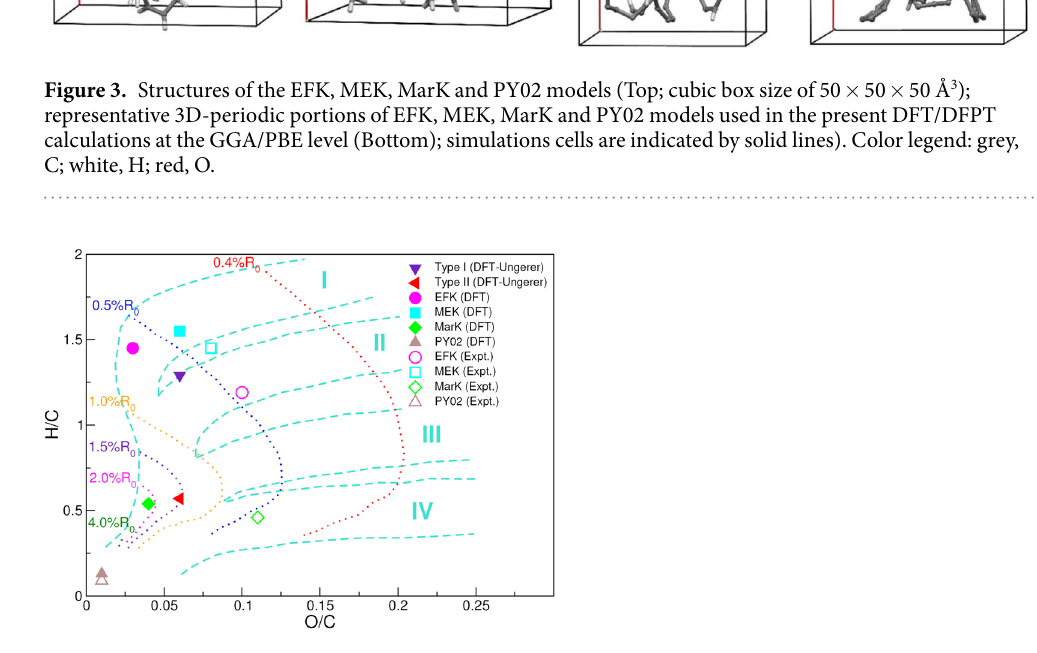
samples (as well as in the Marcellus sample to some extent) originates from C–S stretching. The modes below this frequency are due essentially to complex, collective ring vibrational modes. In addition to the type-I and -II models proposed by Ungerer et al . 4 , complex kerogen structures based on the sophisticated EFK, MEK, MarK and PY02 models (cf. Fig. 3) recently proposed by Bousige and co-workers 5 were also used to simulate IR spectra. These four molecular models with a density of 1.2 g/cm 3 were built to represent an immature type-II kerogen from the carbonate-rich Eagle Ford Play (EFK; H/C = 1.19; O/C = 0.10; 0.65% R 0 ), an immature sulphur-rich type-II kerogen from the Middle East (MEK; H/C = 1.45; O/C = 0.08; 0.55% R 0 ), a mature type II kerogen from the clay-rich Marcellus Play (MarK; H/C = 0.46; O/C = 0.11; 2.20% R 0 ), and a shun- gite from Russia (PY02; H/C = 0.09; O/C = 0.01) sharing many features with excessively mature kerogen 5 . The 3D-periodic portions of EFK, MEK, MarK and PY02 models used in the present DFT/DFPT calculations are also displayed. These smaller models have somewhat different H/C and O/C ratios (see Fig. 4) and lower densities than the samples characterized experimentally ( i.e ., EFK: H/C = 1.45, O/C = 0.03, ρ = 0.7 g/cm 3 ; MEK: H/C = 1.55, O/C = 0.06, ρ = 0.8 g/cm 3 ; MarK: H/C = 0.54, O/C = 0.04, ρ = 0.6 g/cm 3 ; PY02: H/C = 0.13, O/C = 0.01, ρ = 0.5 g/ cm 3 ). The models used in DFT/DFPT calculations (cf. Fig. 3) contained 174 (EFK), 165 (MEK) and 119 (MarK